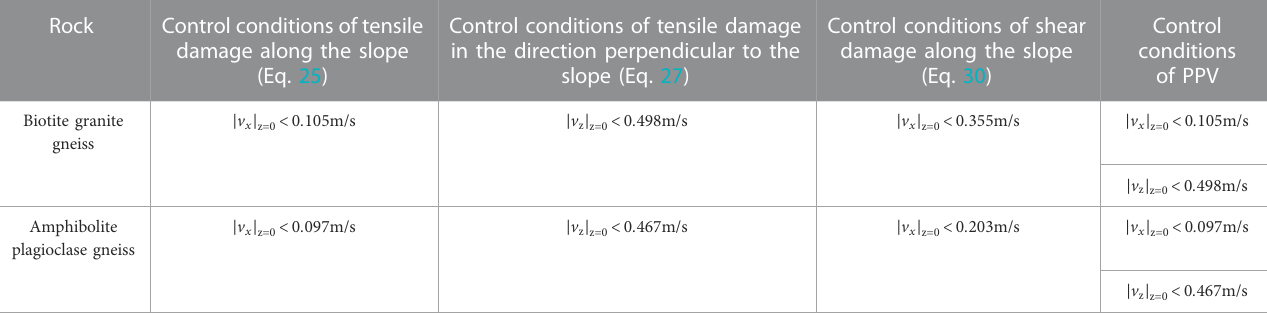
TABLE 6 Calculation results of vibration speed control value. Rock Control conditions of tensile damage along the